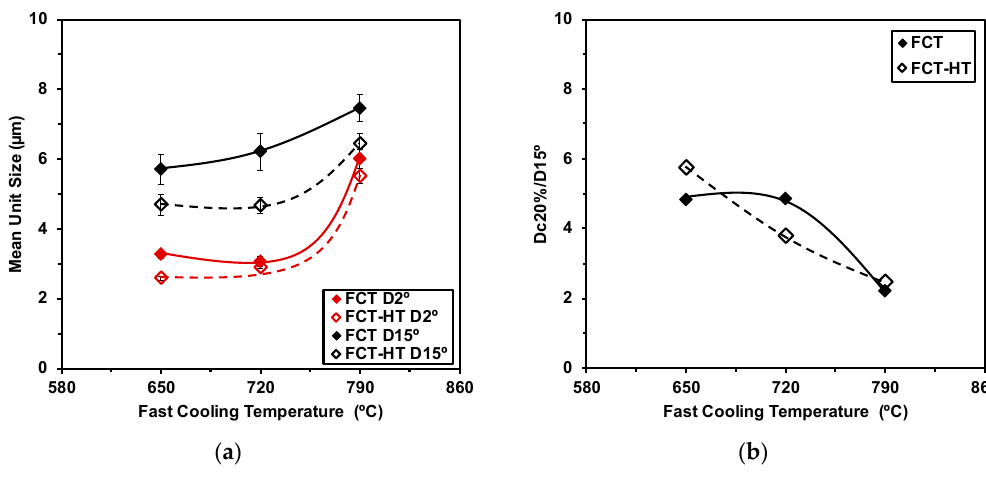
Figure 9. ( a ) Influence of the Fast Cooling Temperature and the induction heat treatment on the average unit size, using different threshold misorientation criteria: low angle (2°) and high angle (15°) boundaries. ( b ) Effect of FCT on the on Dc20%/D15°.